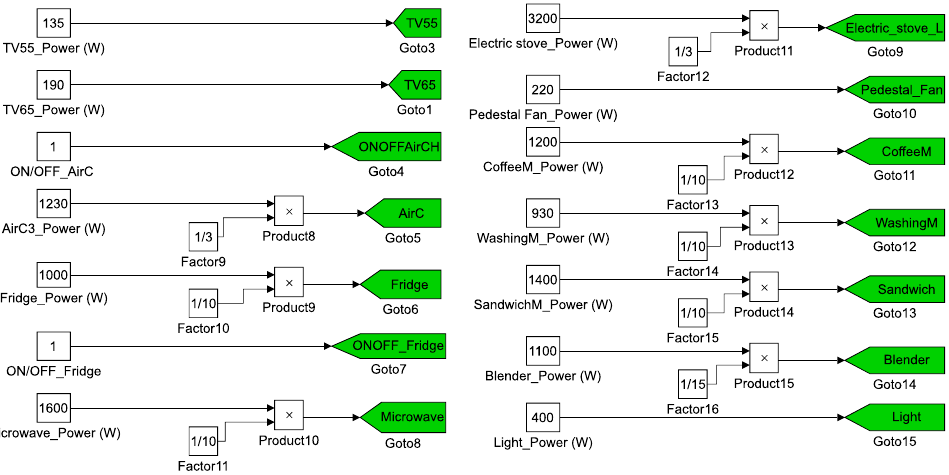
Figure 6. Typical appliance power values running on the Simulink Model.